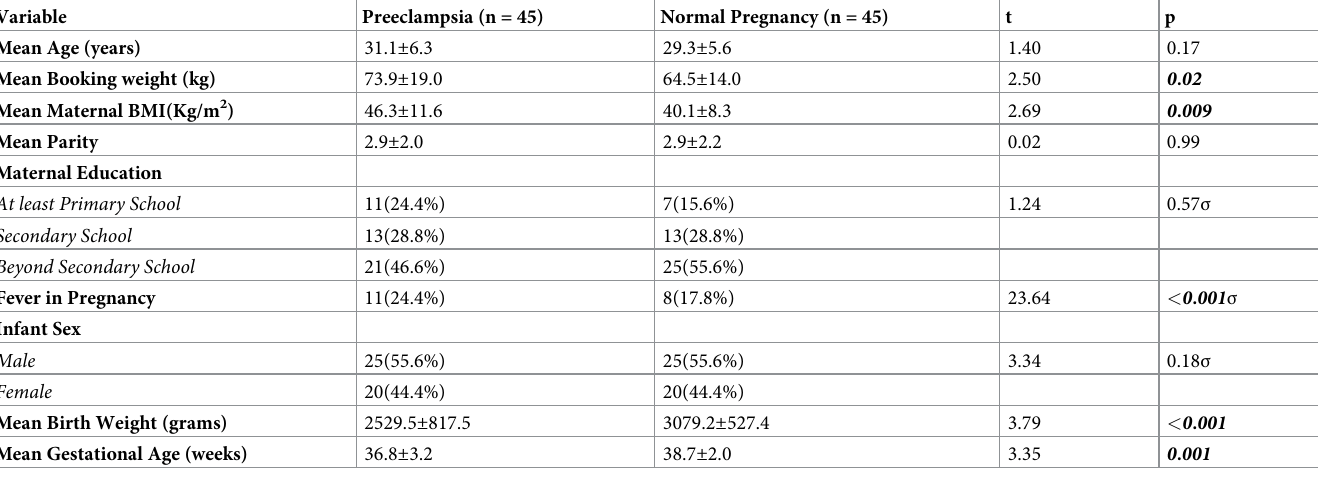
Table 1. Baseline demographics and clinical characteristics of the study population (N = 90).